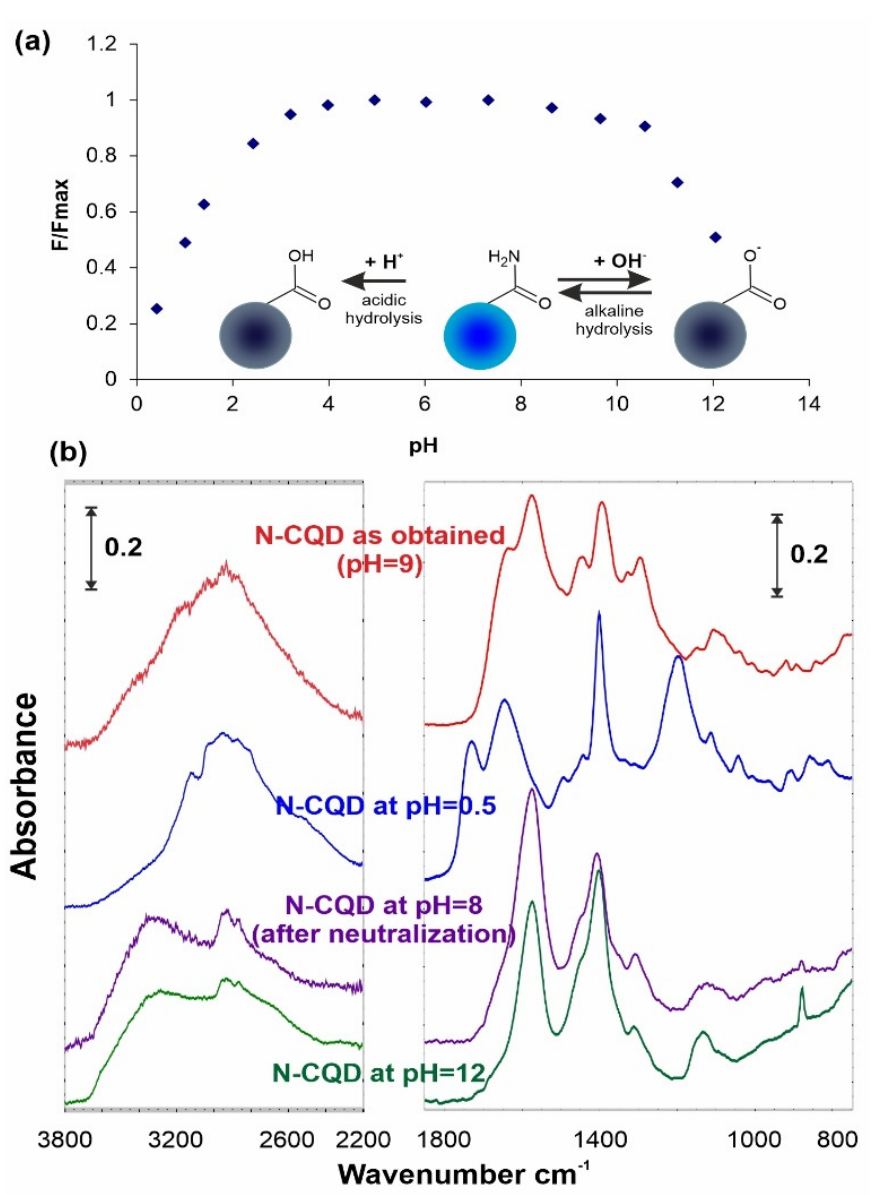
Figure 5. Effect of pH on ( a ) N-CQD fluorescence intensity and ( b ) N-CQD surface